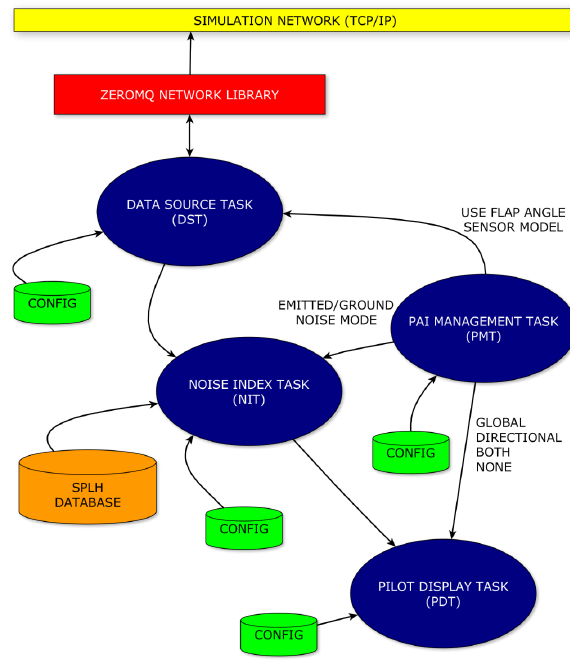
Figure 33: PAI Demonstrator software